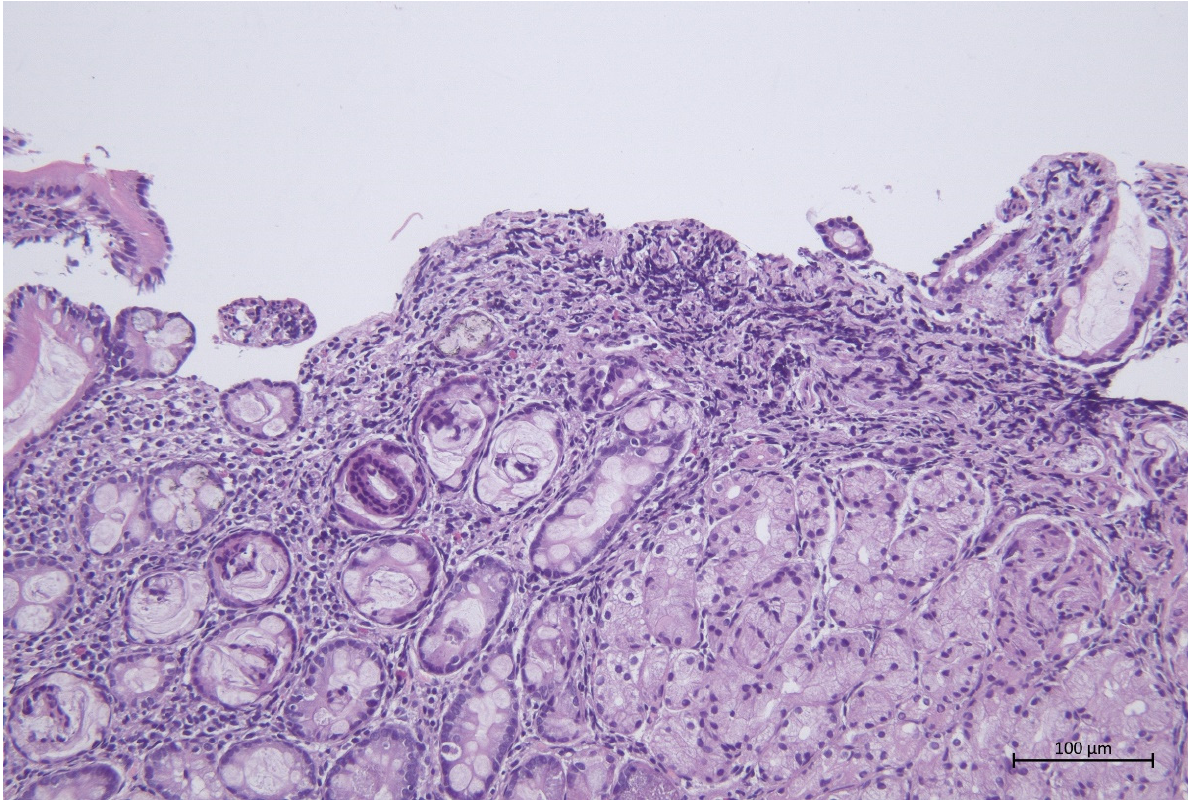
Figure 1. Erosive duodenitis, 200× magnification.